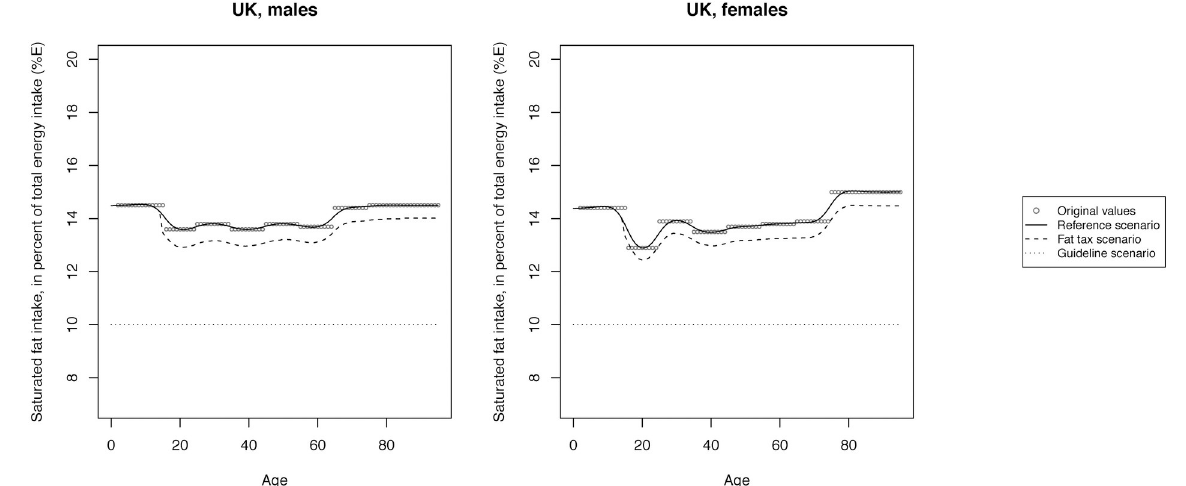
Fig 8. Mean saturated fat intake across reference, fat tax and guideline scenario in the UK.